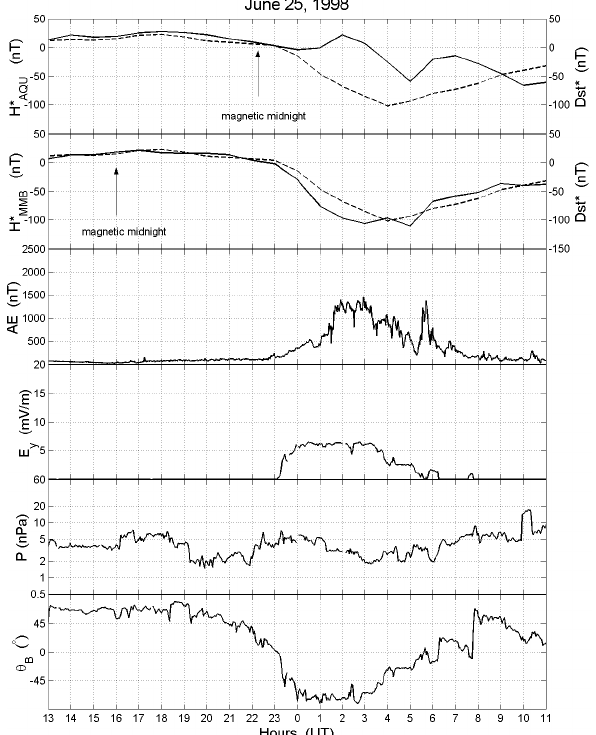
Fig. 4. From top to bottom the hourly values of the H * component at AQU and MMB (solid line) and the D st * index (dashed line), the AE index, the dawn-dusk solar wind electric field, the solar wind dynamic pressure and the interplanetary magnetic field θ angle for the 25 June 1998